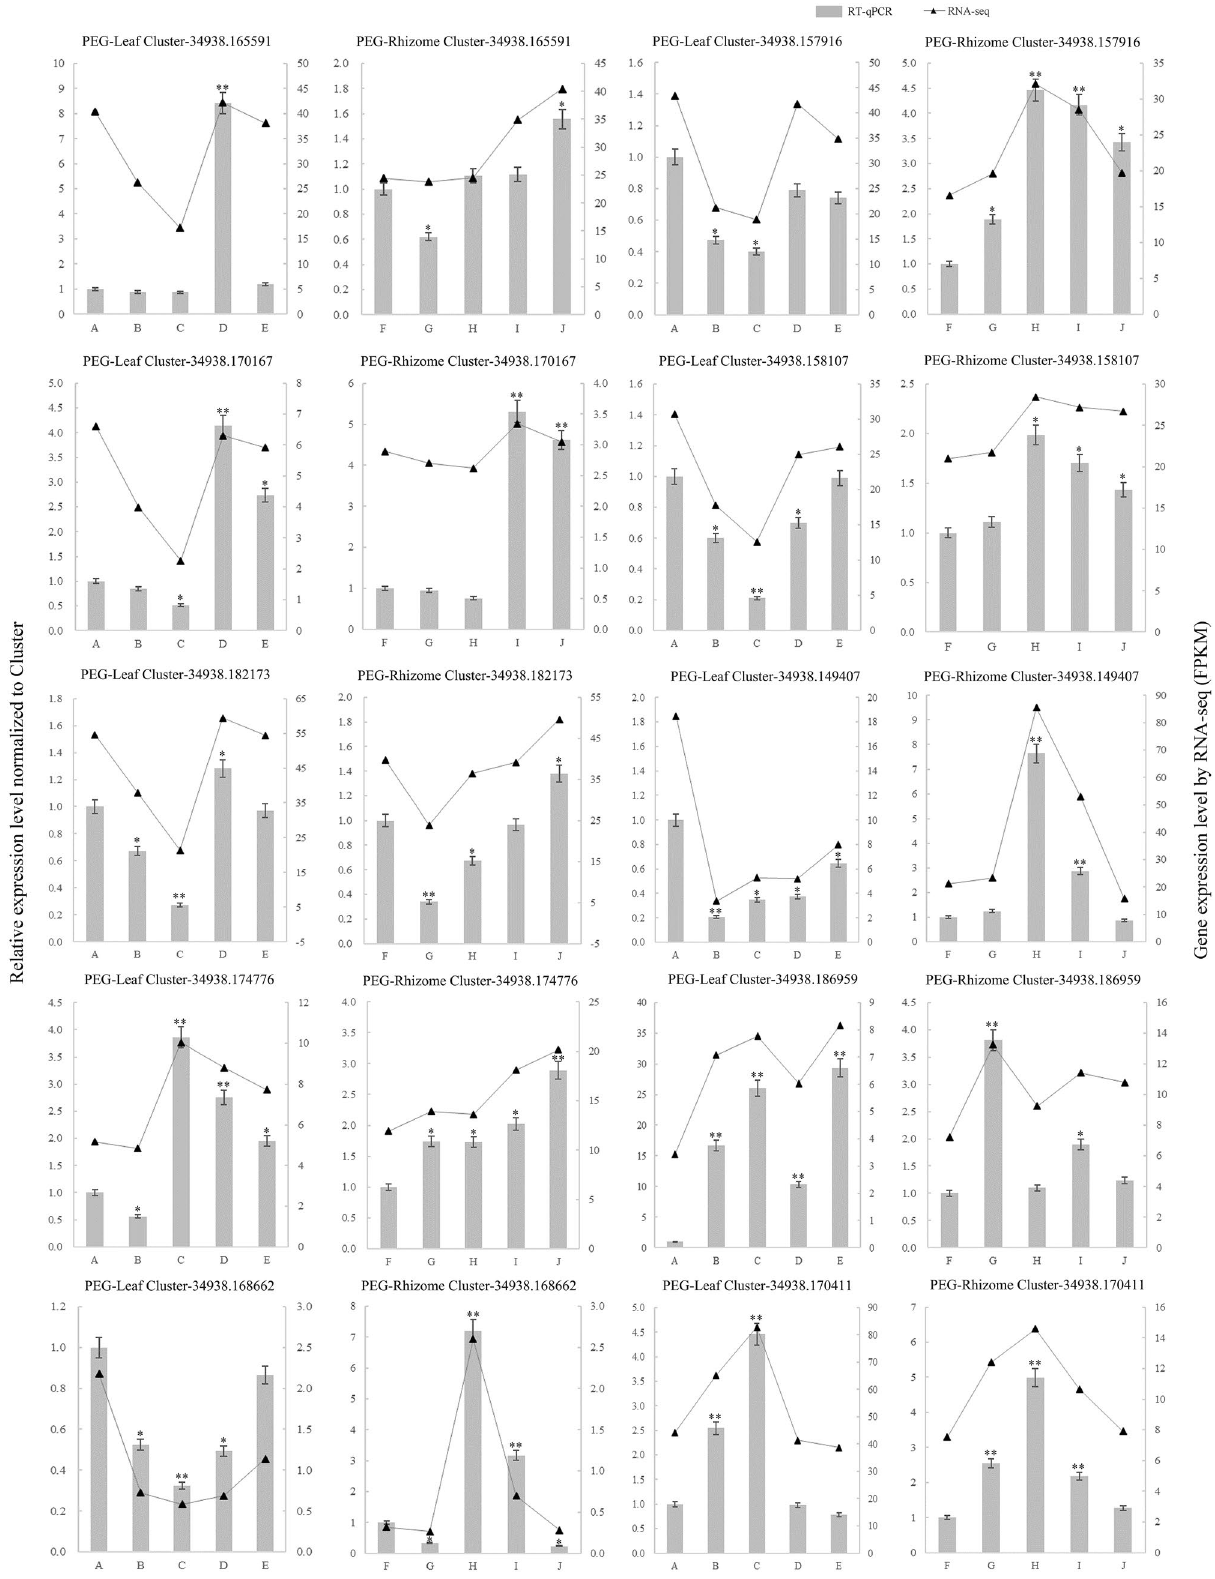
Figure 7. Expression of 10 DEGs in response to drought stress treatment. Vertical bar charts with simple error bars (left y-axis) represent quantitation of 10 genes transcripts in leaf and rhizome samples using RT-qPCR. Values are means ± SE (n = 3). Line graph with triangle (right y-axis) represents transcript abundance (FPKM) of leaf and rhizome samples for each gene detected by RNA-seq. Asterisks (* or **) represent the significant differences at p < 0.05 or p < 0.01 when compared to the control, respectively (Student’s t-test). The A–E indicates the ‘Little Dream’ of leaves under stress at 0, 6, 12, 24, and 48 h, respectively, the F–J were ‘Little Dream’ of rhizomes under stress at the same time